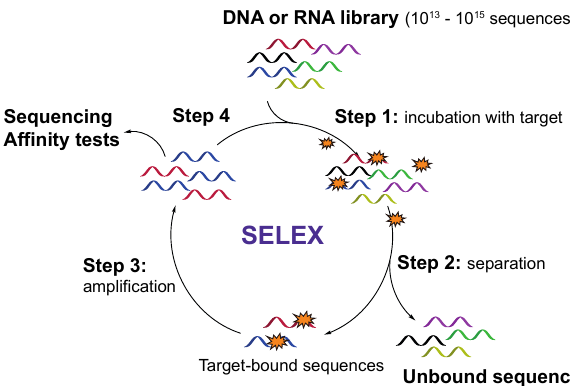
Figure 2. Schematic representation of a conventional SELEX process for the selection of aptamers with high affinity against a target of interest.